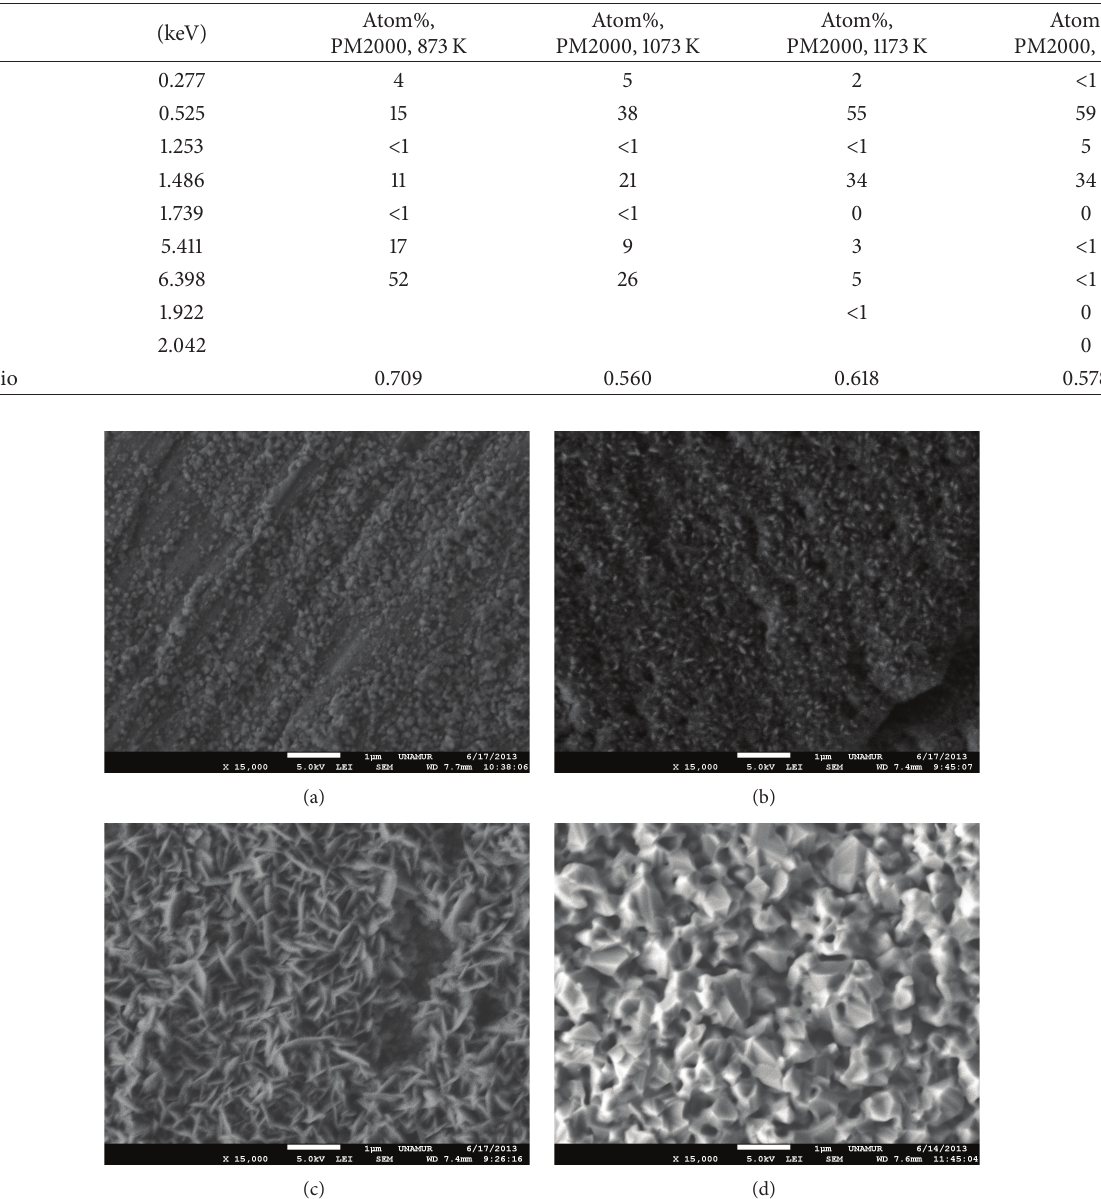
Figure 2: Typical morphology of the surface scales of PM2000 after 7h exposure at 873 K (a), 1073 K (b), 1173K (c), and 1473K